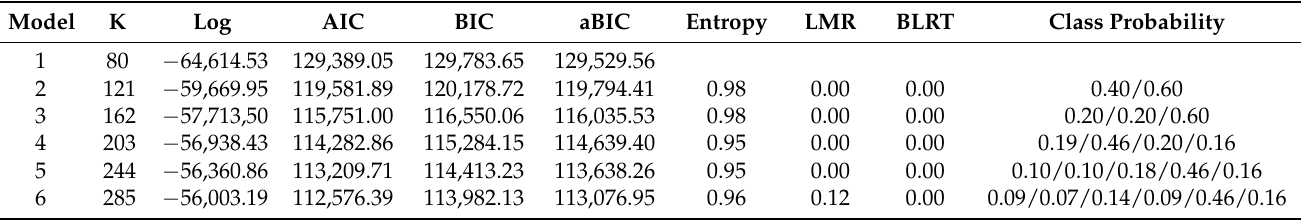
Table 1. Fit indices for the latent class models on the cyberbullying bystander for the total sample.